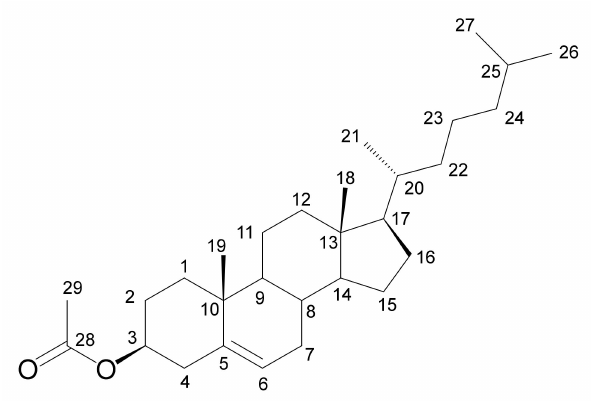
Figure 3. Cholesteryl acetate and carbon numbering.